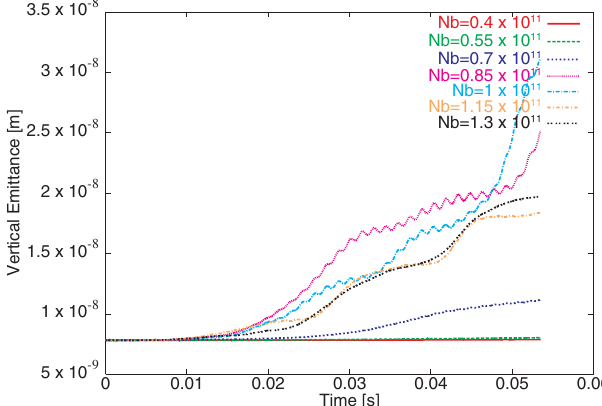
FIG. 7. (Color) Vertical emittance as a function of time for different values of electron-cloud density, and Q 0 (cid:2) 2 .